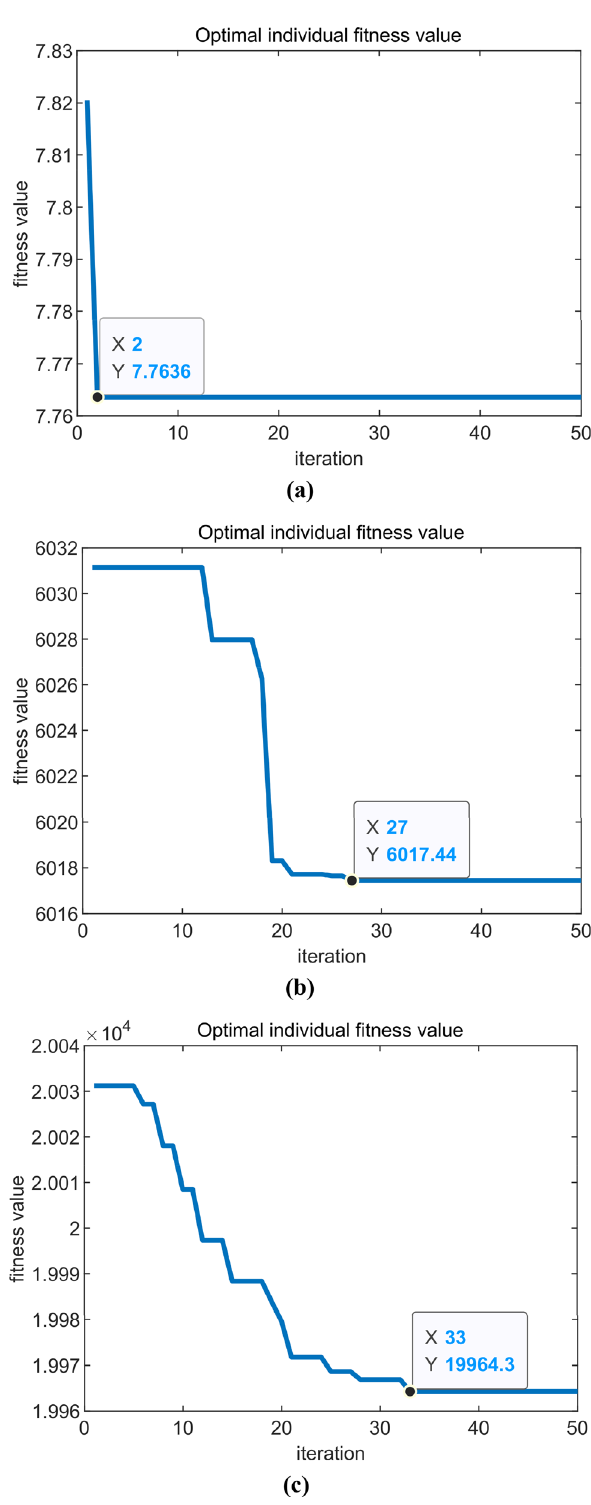
Fig. 8 Optimization of scale factors for PF-PI controller using a ITAE, b ITSE, and c ISE Fig. 9 Optimization of fitness values for PF-PI controller using a ITAE, b ITSE, and c